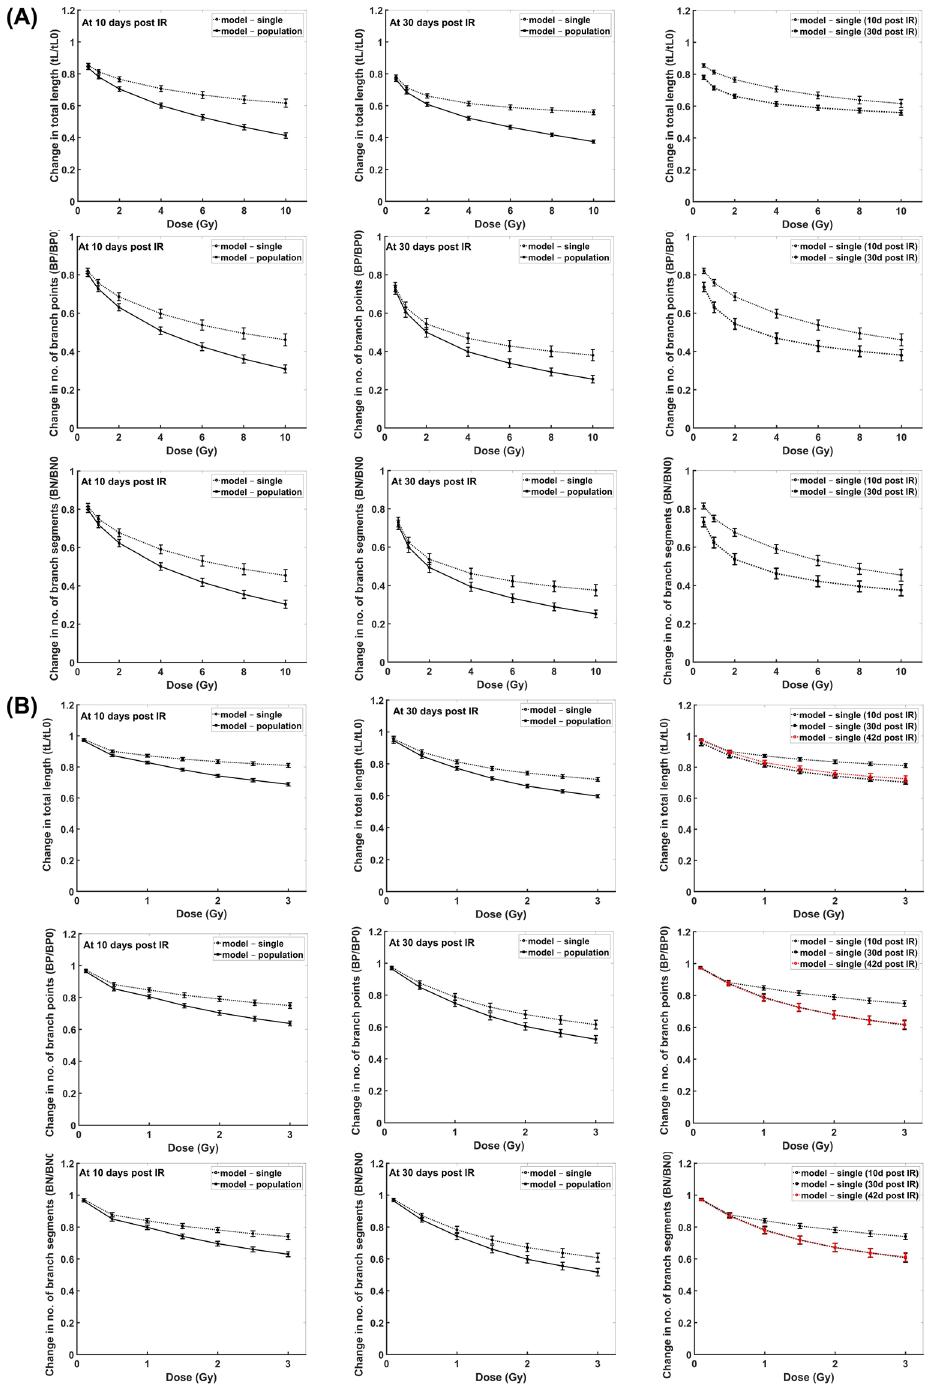
Figure 5. Comparison of GCL dendritic damage measurements from single neuron (dashed line) with population of neurons (solid line) induced by ( A ) gamma rays and ( B ) proton radiation at different post exposure times. (Left) single vs. population at 10 days, (Middle) single vs. population at 30 days, (Right) single at diff post exposure